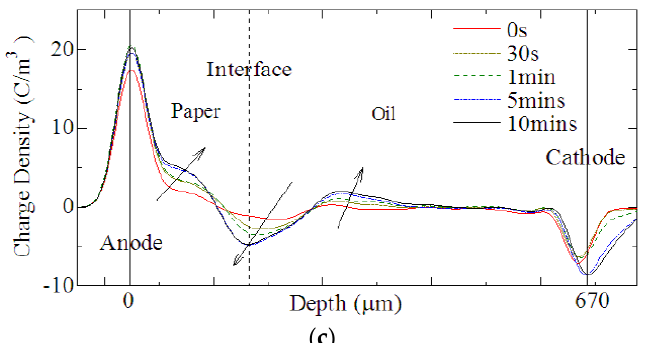
Figure 14. Space charge development under an average field of 20 kV/mm with different thickness of oil [28]. ( a ) 0.17 mm oil ‐ immersed ‐ paper with 0.3 mm oil ( b ) 0.17 mm oil ‐ immersed ‐ paper with 0.4 mm oil; ( c ) 0.17 mm oil ‐ immersed ‐ paper with 0.5 mm oil.